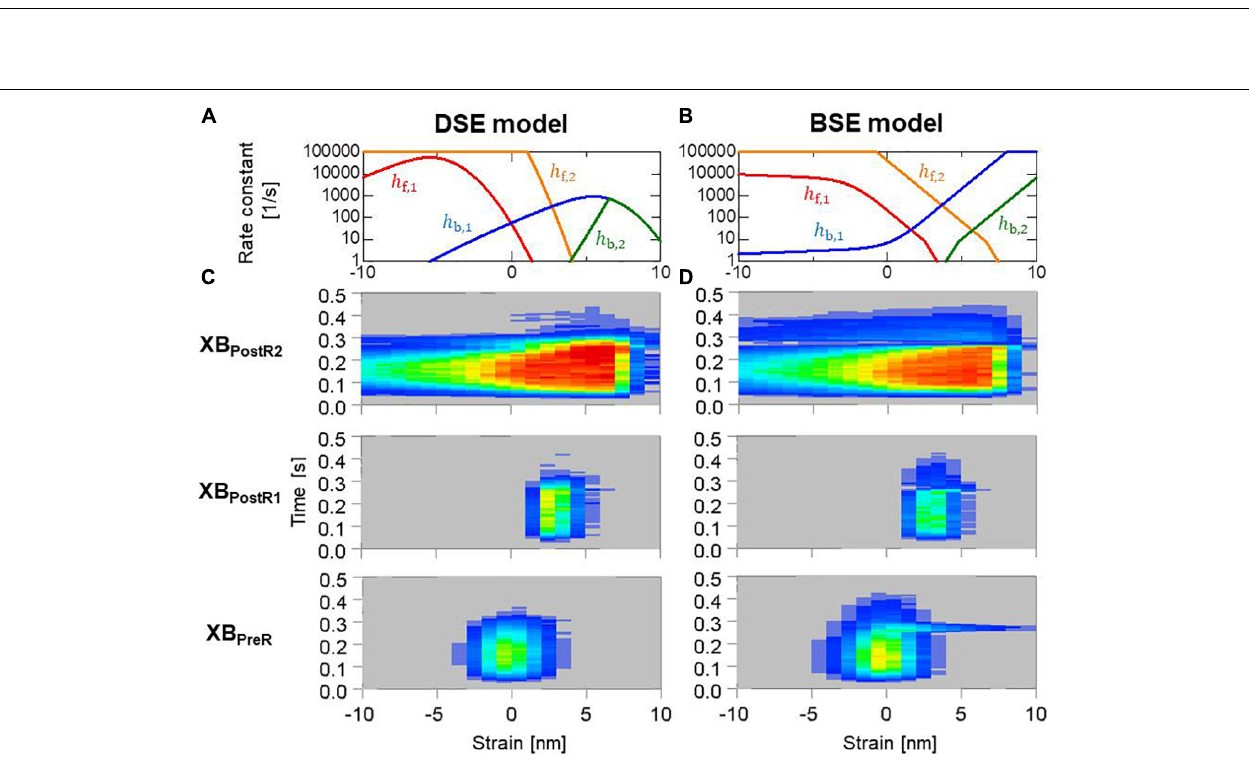
FIGURE 13 | (A,B) Rate constants in the logarithmic scale between the binding states, and (C,D) time transients of the distribution of binding states in the rod strain space in the half-sarcomere models imbedded at the endo lateral left ventricular wall (elements inside a sphere of 3 mm radius). Red and blue indicate high and low density, respectively. Panels (A,C) and panels (B,D) are for the DSE and BSE models, respectively.